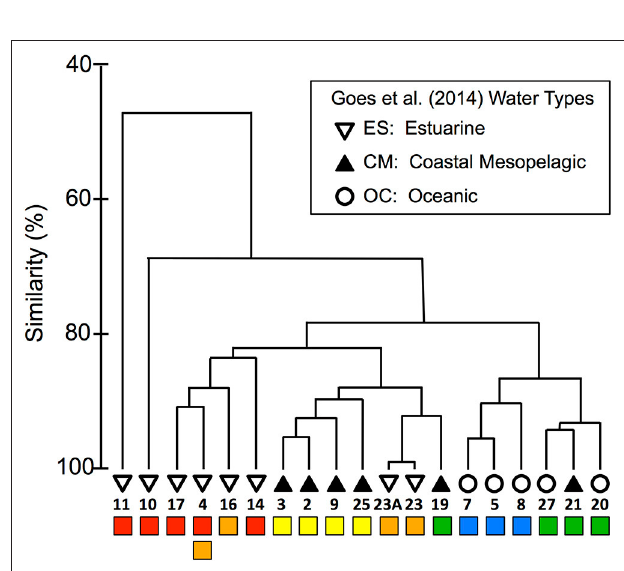
FIGURE 4 | Modified dendrogram from Goes et al. (2014) based on the Bray–Curtis similarities of ALF fluorescence data measured on surface station samples from KN197-8. The water types defined by Goes et al. (2014) are shown with the black and white symbols and are labeled with the station number. Below the station labels, we have added colored squares corresponding to our habitat-type categorizations in Figure 2